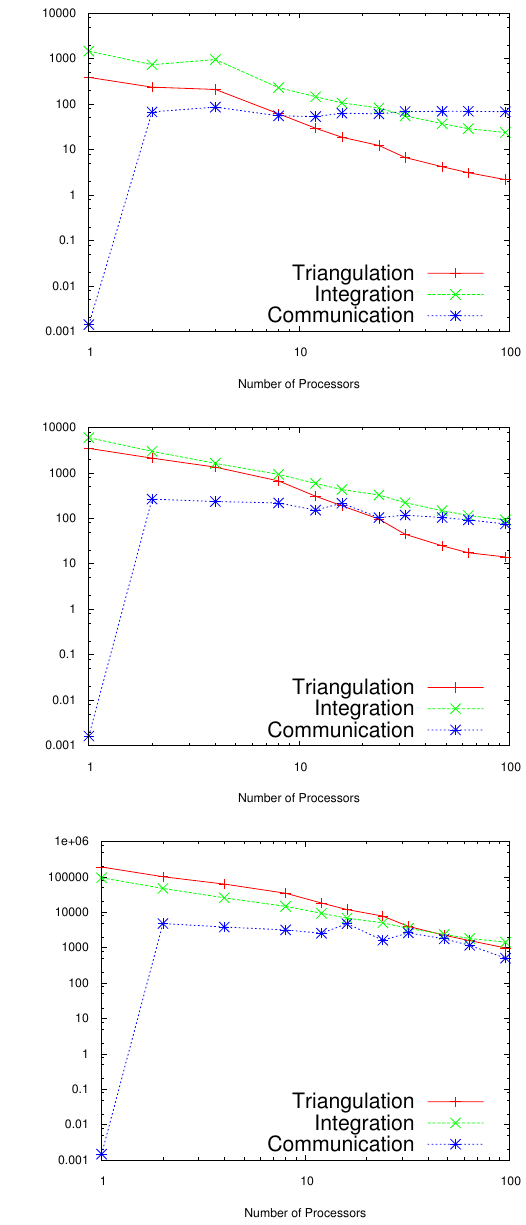
Fig. 9. Timing results for MPI-SCVT vs. number of processors for three different problem sizes. Red solid-lines represent the cost of computing a triangulation, whereas green-dashed lines represent the cost of integrating all Voronoi cells, and blue-dotted lines represent the cost of communicating each region’s updated point set to its